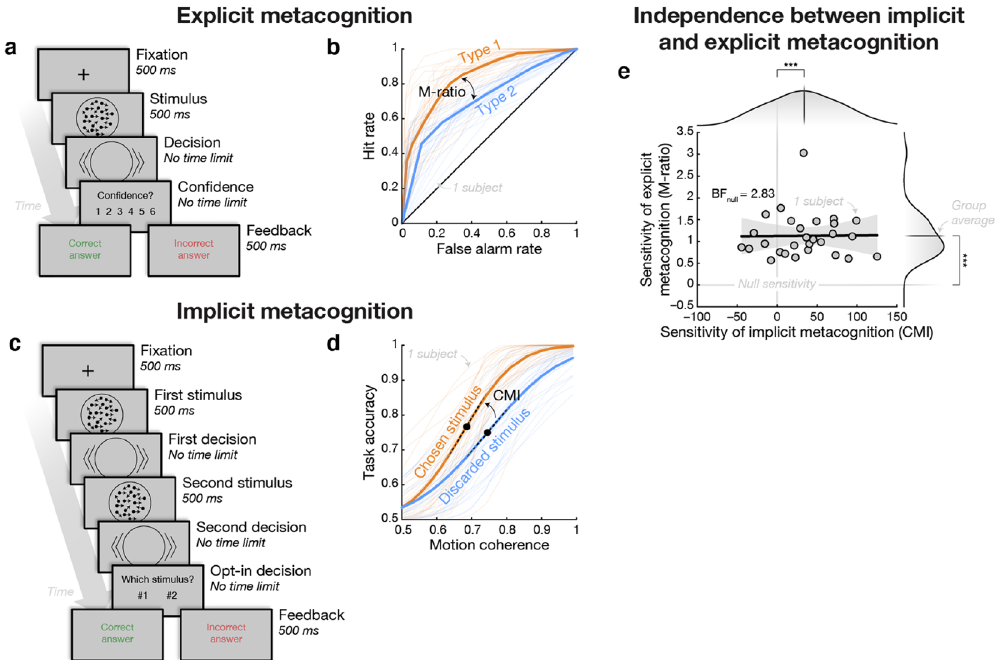
Figure 2. Independence of implicit and explicit metacognitive sensitivities. ( a ) Explicit metacognition task . Representative trial of the explicit metacognition task: after reporting their orientation judgment, participants were asked to report their confidence in this orientation judgment on a scale from 1 (guess) to 6 (certainty). Feedback was delivered at the end of each trial. ( b ) Sensitivity of explicit metacognition . The sensitivity of explicit metacognition was measured using the M-ratio, which quantifies the amount of decision information available to the confidence judgment, here depicted as the difference between type 1 (decision) and type 2 (confidence) ROC curves 35 . ( c ) Implicit metacognitive task . Representative trial of the implicit metacognition task: after reporting their orientation judgment for two successive RDM stimuli, participants were asked to report the stimulus for which they judged more likely to be correct. Feedback on the chosen stimulus was delivered at the end of each trial. ( d ) Sensitivity of implicit metacognition . The sensitivity of implicit metacognition was measured as the difference in slopes between psychometric functions corresponding to the chosen minus discarded stimuli, divided by the average slope across both conditions; a measure we refer to as CMI 25,30 . ( e ) Independence between explicit and implicit metacognition . Metacognitive sensitivities were estimated for each participant separately in the explicit and implicit metacognition tasks. Measures are not correlated across participants suggesting they relate to independent metacognitive processes (see Table S3). Stars indicate significance: * P < 0.05, ** P < 0.01, and *** P <